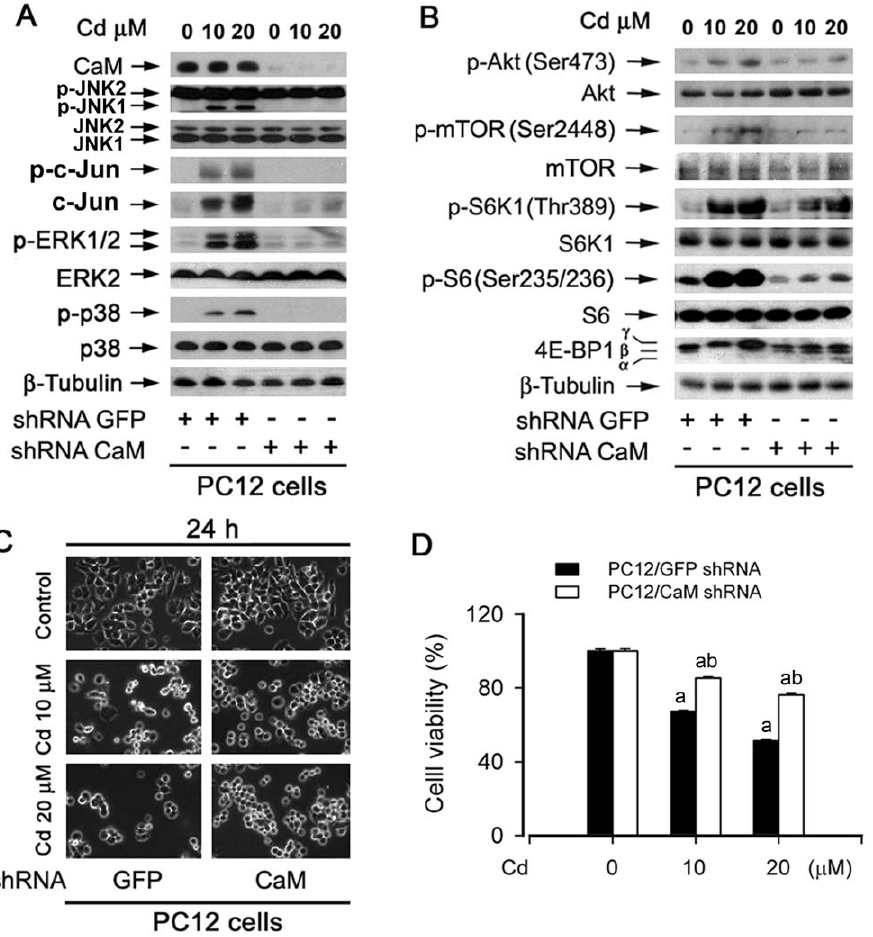
Figure 5. Downregulation of CaM attenuates Cd activation of MAPK/mTOR pathways and apoptosis in neuronal cells. PC12 Cells infected with lentiviral shRNAs to CaM and GFP, respectively, were exposed to Cd (0–20 m M) for 4 h (A,B) or 24 h (C,D), followed by Western blotting with indicated antibodies (A, B), cell morphological analysis (C) or cell viability assay (D), as described in Materials and Methods. Note: CaM was downregulated by , 90% by lentiviral shRNA to CaM, compared with the control (lentiviral shRNA to GFP), by densitometry using NIH Image J. Results are presented as mean 6 SE; n =6. a P , 0.01, difference vs. control group; b P , 0.01, CaM shRNA group vs. GFP shRNA group.